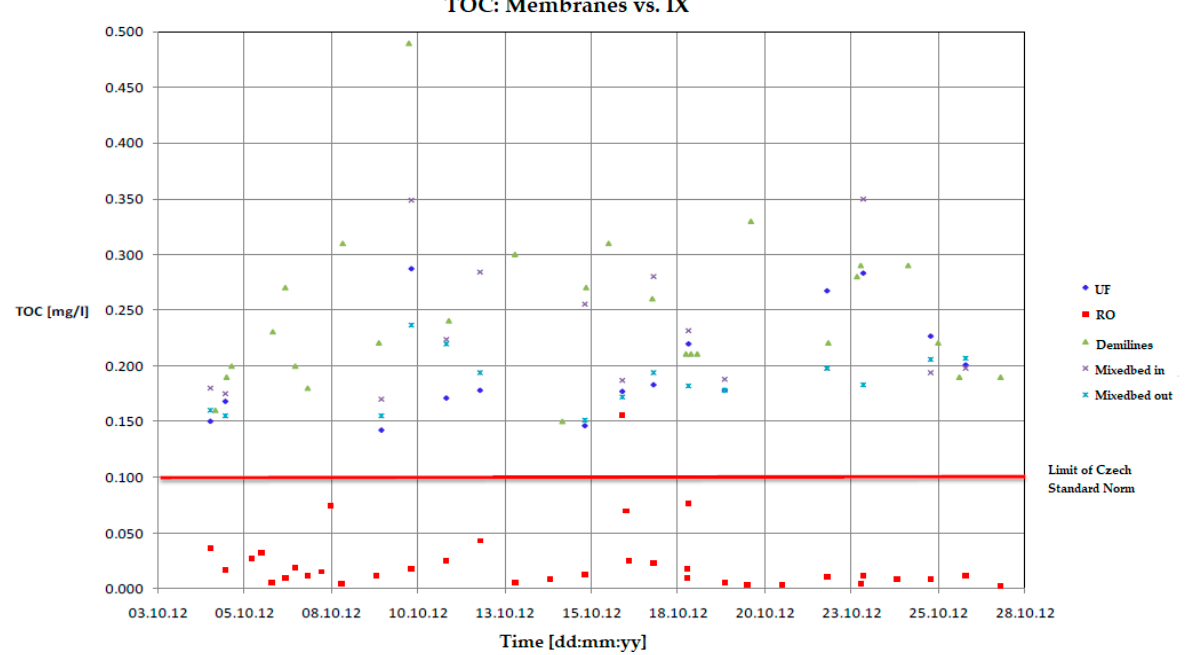
Figure 9. Decreasing TOC in demineralized water outlet from mixed bed columns in Temelín Nuclear Powerplant (CEZ group), secondary circuit. TOC online analyzer Mettler Toledo 6000TOCi.